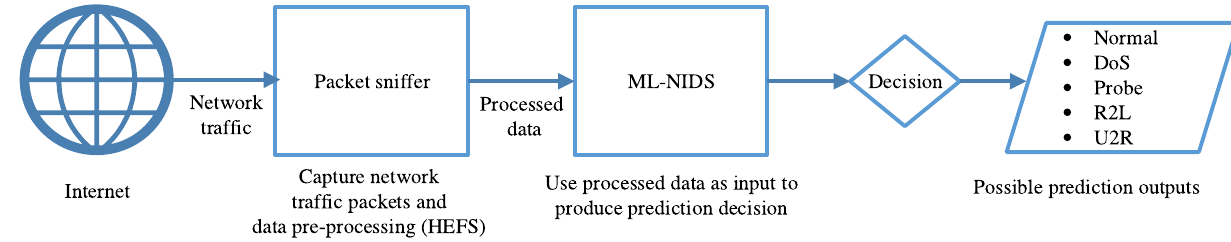
Fig. 3 The scheme of HEFS-based NIDS